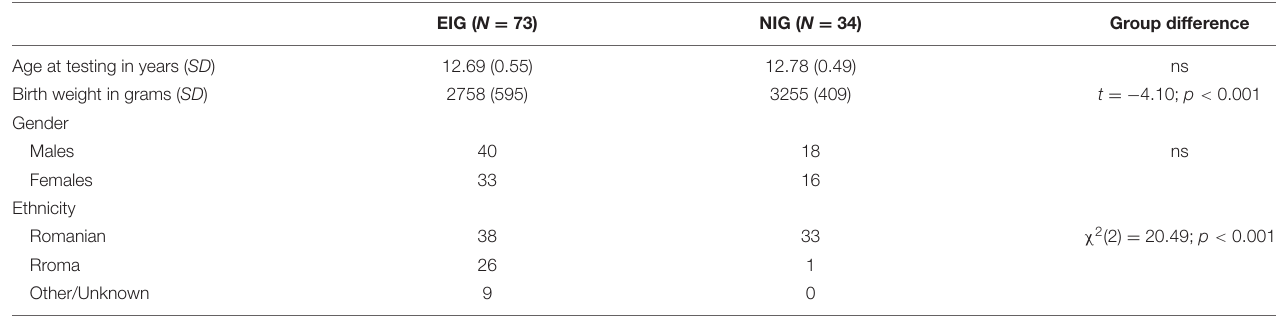
Abbreviations: EIG, ever institutionalized group; NIG, never institutionalized